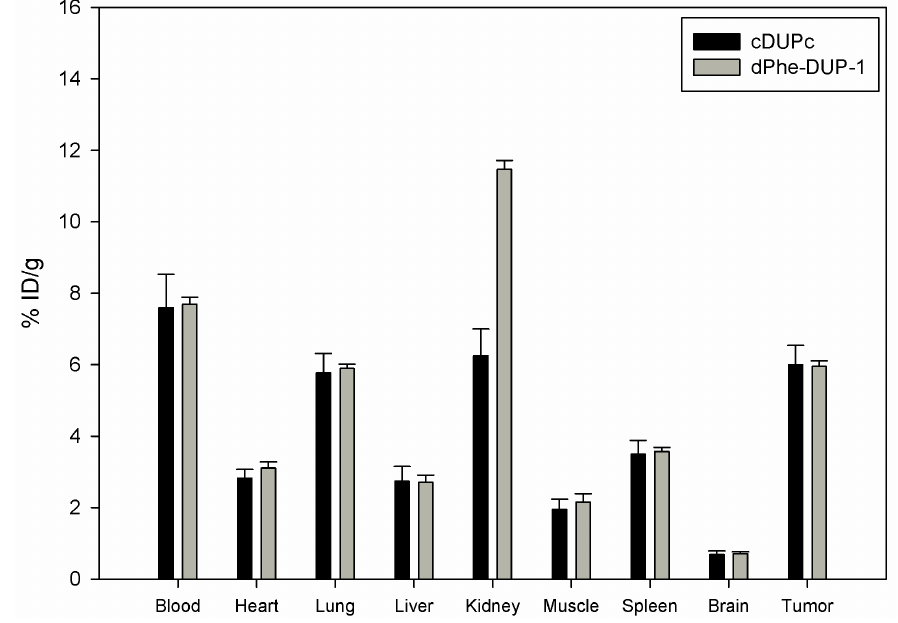
Figure 6. Organ distribution of 131 I-cDUPc and 131 I-dPhe-DUP-1 in Balb/c nu/nu mice carrying PC-3 tumors. Activity concentration (% ID/g) in tumor and control organs is measured after 15 min (n = 3 animals) radioligand circulation in the mice. Mean values and standard